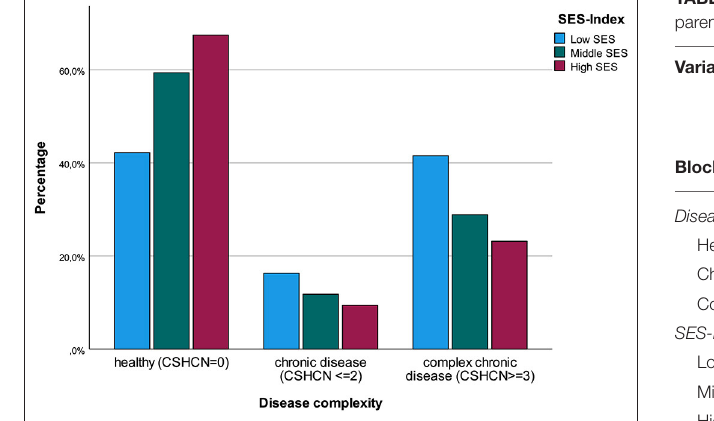
FIGURE 1 | Stratified analysis of disease complexity by socioeconomic status ( N = 1619). SES, socioeconomic status; CSHCN, Children with Special Health Care Needs Screener.